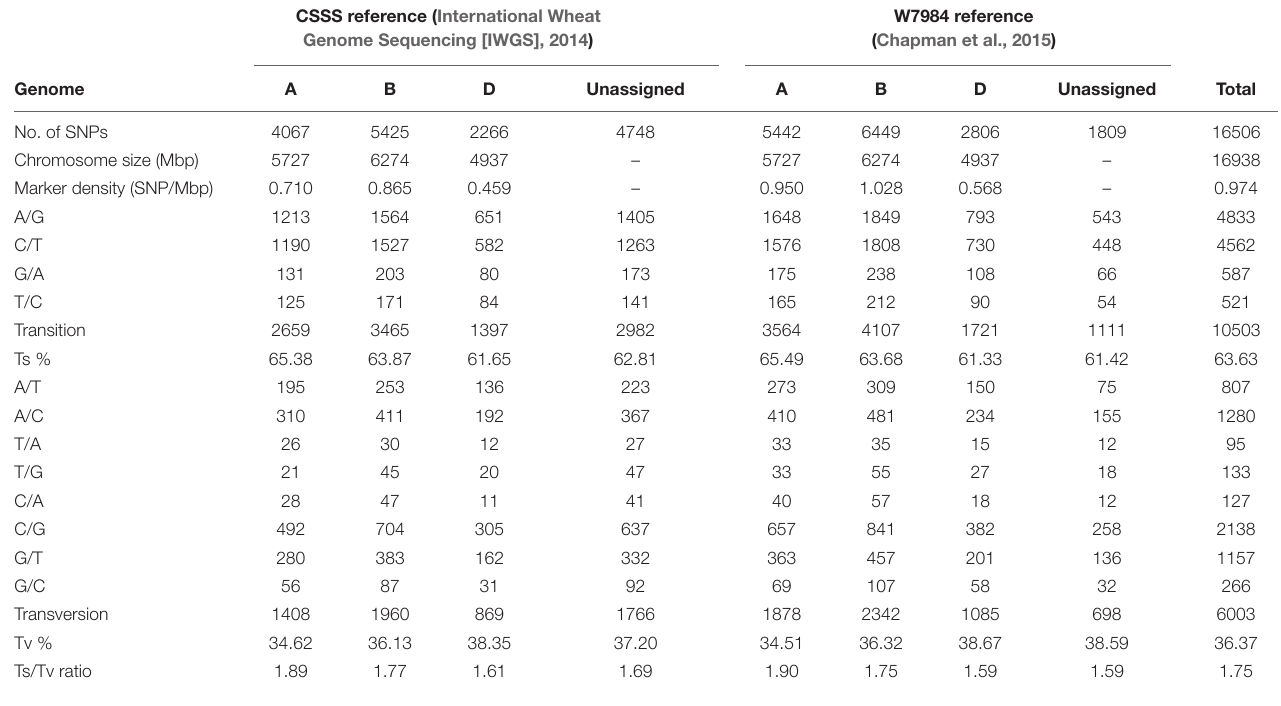
TABLE 1 | A summary of single nucleotide substitutions identified in the three homoeologous wheat genomes based on CSSS and W7984 reference